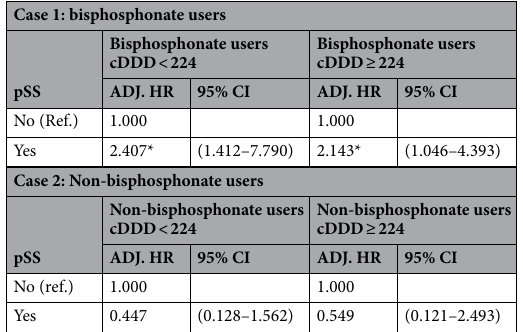
Table 3. Stratified analysis of the cDDD for bisphosphonate and non-bisphosphonate users. (1) *0.01 ≤ p < 0.05, **0.0001 ≤ p < 0.01, *** p < 0.0001. (2) ‡ ADJ. HR was adjusted by sex, comorbidities, and age at the initiation of bisphosphonate use. cDDD cumulative dose with defined daily dose, 95% CI 95% confidence interval, ADJ. HR adjusted hazard ratio, Ref reference.